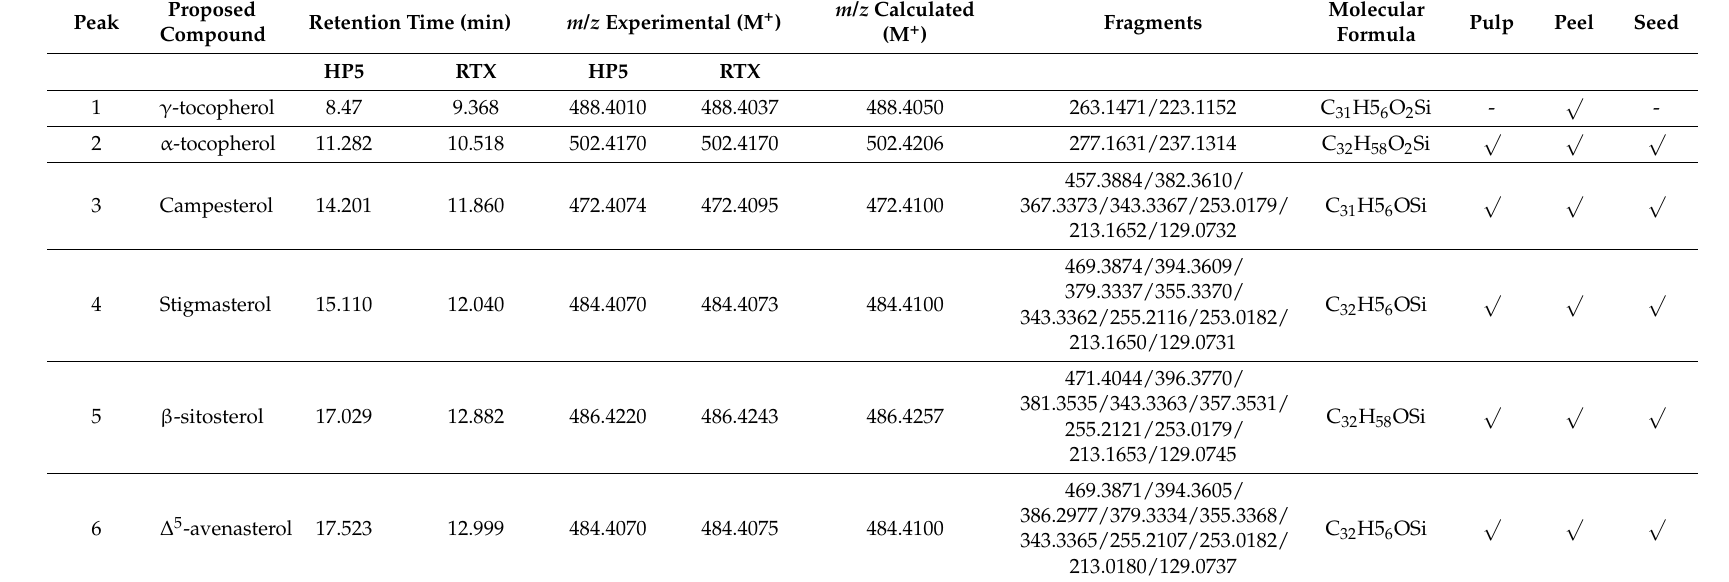
Table 3. Phytosterols and tocopherols identification in mango pulp, peel, and seed by